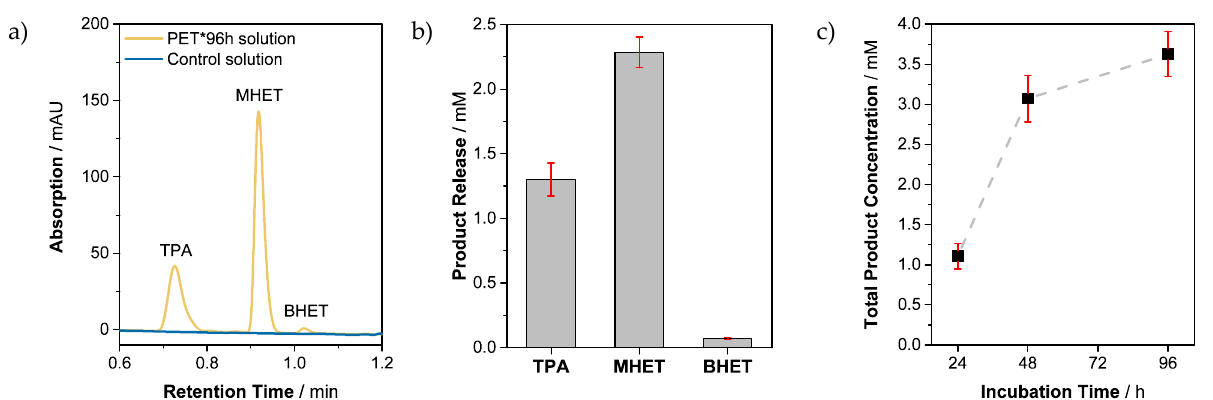
Figure 2. Analysis of soluble products. ( a ) UHPLC results of the control buffer solution (blue) and enzyme buffer solution (orange) of PET*96 h. For the control buffer solution, no release products could be detected. ( b ) Product concentrations of PET*96 h to display the product composition in mM and ( c ) total product concentration of PET*24 h, PET*48 h, and PET*96 h solution versus incubation time.